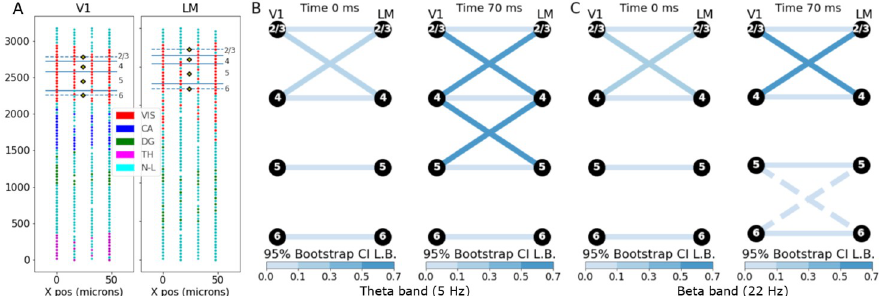
Fig 6. Phase coupling in Neuropixels data. (A) Neuropixels probe LFP electrode locations (circles) for V1 (left) and LM (right), colored by putative region (VIS: visual cortex, CA: Cornu Ammonis, DG: dentate gyrus, TH: thalamus, N-L: no label). Putative cortical layer boundaries are overlaid on the red visual area electrodes with layer numbers indicated along the right side. Along the center of the probe are the locations we chose for CSD estimation (yellow diamonds), with one location centered in each cortical layer. (B) Torus graph phase coupling graphs based on theta oscillations at two time points relative to the stimulus. Edges shown for torus graph p < 0.0001. Edge color indicates the lower bound of a 95% bootstrap confidence interval on the partial PLV value. It appears the strongest edges were between V1 and LM at similar cortical depths, with some evidence that edges were stronger at 70ms than at 0ms. (C) Similar to B, but for beta oscillations; dashed edges indicate edges with weaker evidence (torus graph p < 0.001). Similar to theta band, the connection patterns were mostly across similar layers but appeared slightly stronger at 70ms compared to